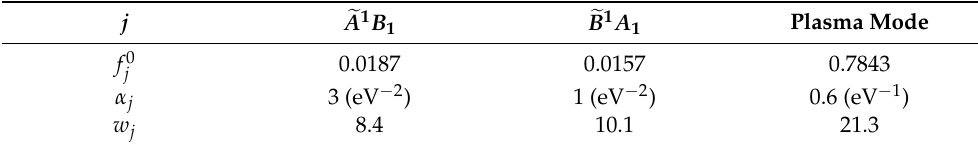
Table 2. Parameters used in Equations